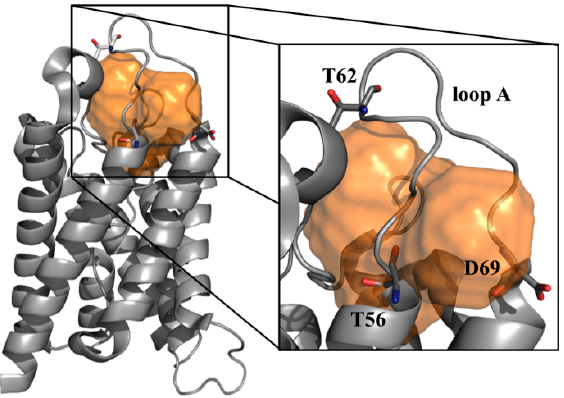
Figure 7. Identified druggable cavity in hAQP4. Cavity identified in the hAQP4 crystal structure (PDB entry: 3GD8 [21]) by the FLAPsite algorithm. As shown in the zoomed panel, the sole cavity found is located in proximity of the extracellular loop A and close to residues D69, T62 and T56. Adapted from reference [96].